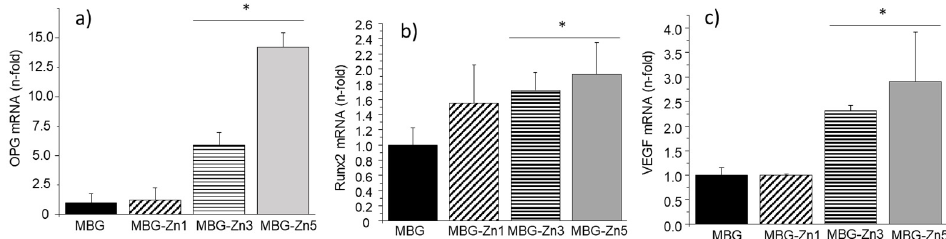
Figure 7. MC3T3-E1 preosteoblast gene expression (measured by qRT-PCR) of OPG ( a ), Runx2 ( b ), and VEGF ( c ) markers in the presence of MBG and ZnO-containing MBGs. * Comparison between MBG (blank) and MBG-Zn3/MBG-Zn5. Statistical significance: * p < 0.05.